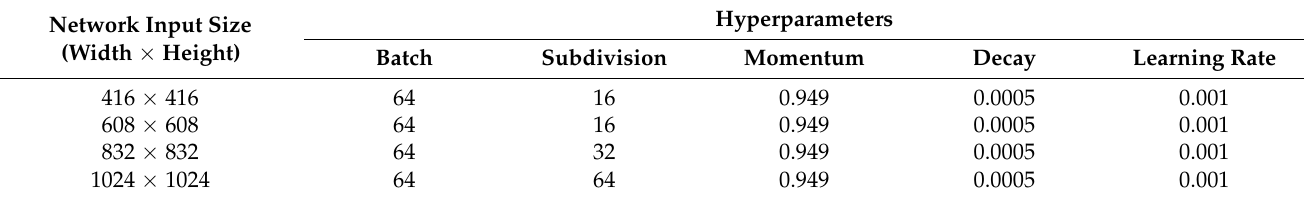
Table 4. YOLOv4 network input sizes and hyperparameters scenario for training and validation.